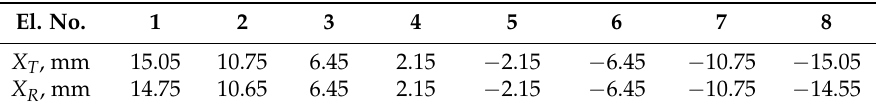
Table 2. Coordinates of array A element centres.